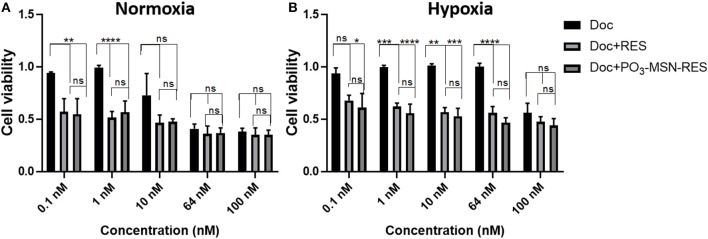
Inhibitory effect of RES and PO3-MSN-RES on hypoxia-induced resistance to Doc in PC3 cells. PC3 cells were cultured with increasing concentrations of Doc (0.1–100 nM), RES, PO3-MSN-RES in (A) normoxia and (B) hypoxia for 72 h and cell viability was determined. Hypoxia induced docetaxel resistance in PC3 cells and docetaxel sensitivity was enhanced after combination with RES and PO3-MSN-RES under hypoxic conditions in PC3 cells. Cell viability was normalized to DMSO and PO3-MSN-Control. Data was presented as Mean ± SEM, n = 3, One-way ANOVA test, Tukey's post-hoc test, ****P < 0.0001, ***P < 0.001, **P < 0.01, *P = 0.0177.